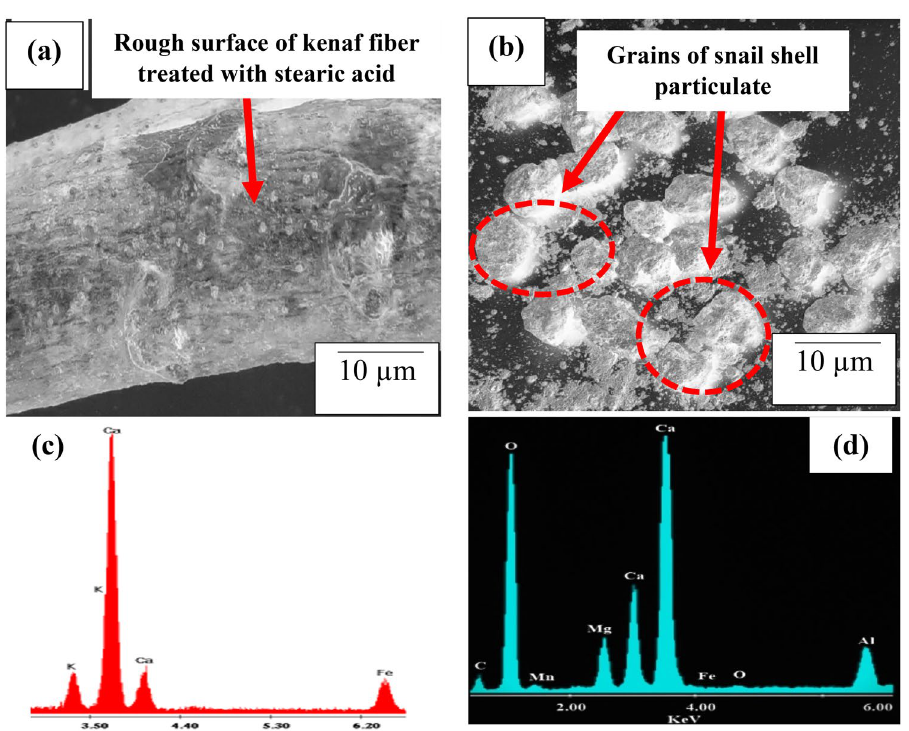
Figure 2. Morphological images of input materials ( a ) kenaf fiber ( b ) Particulate snail shell and EDX spectra for ( c ) kenaf fiber ( d ) Particulate snail shell.